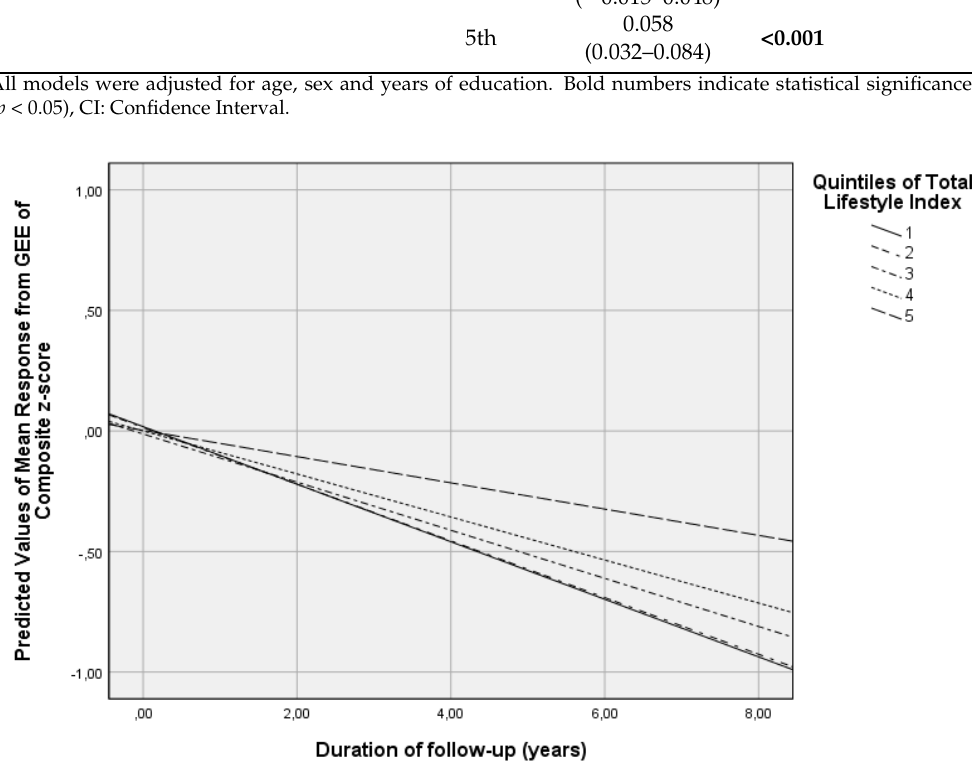
Global Cognition score